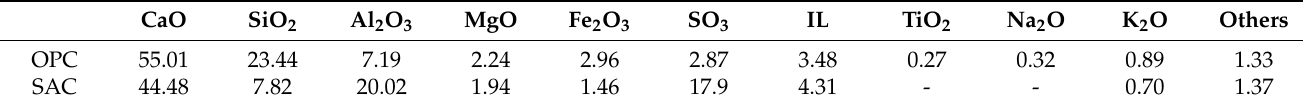
Table 1. Chemical composition (wt.%) of OPC and SAC.